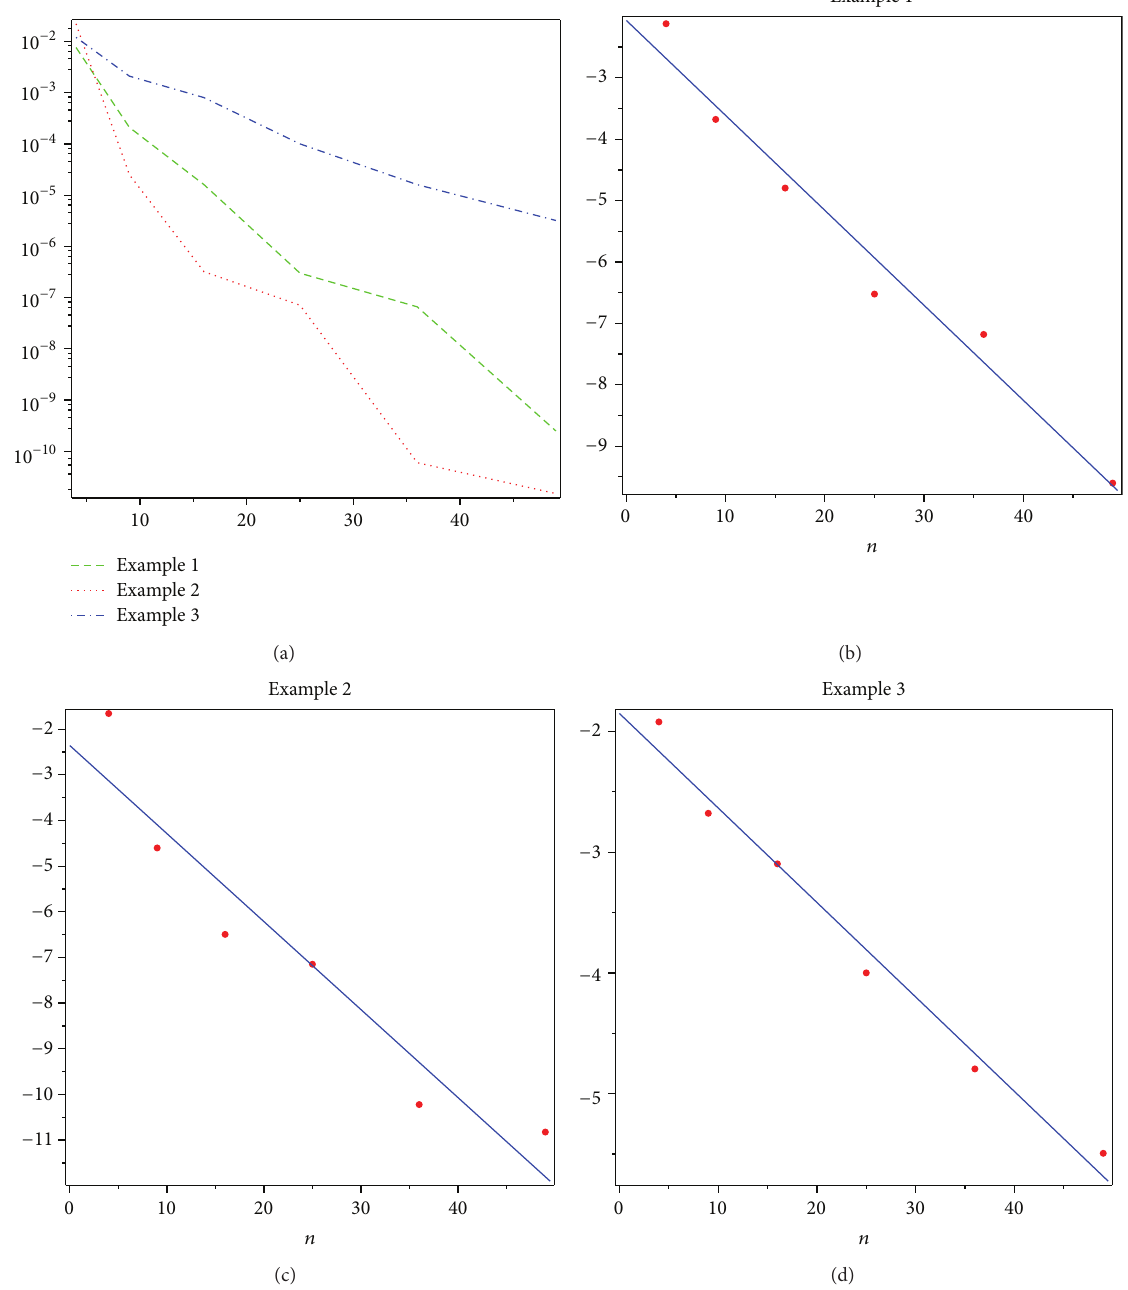
Figure 1: The horizontal axis is related to 𝑛 and the vertical axis shows the corresponding error values. It is perceived that the relation between 𝑛 and log (error) is linear. It confirms 𝑛 can affect error exponentially. We emphasize the spectral accuracy is the most important feature of the method. The relevant data is presented in Tables 1, 2, and